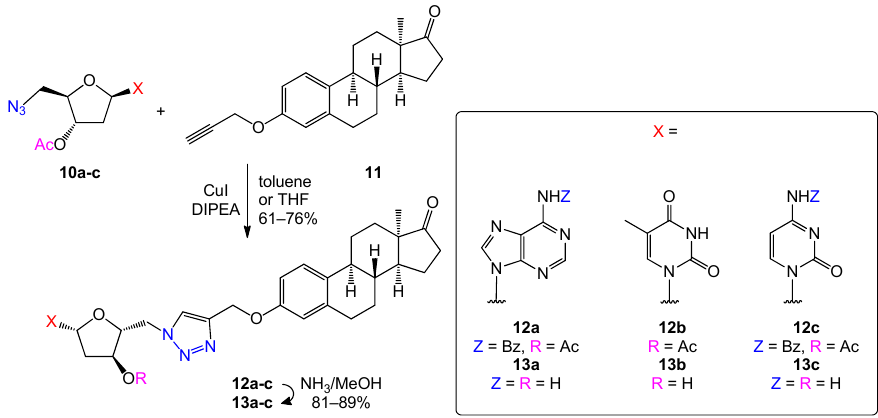
Table 1. Optimization of CuAAC conjugation reaction of 3’- O -acetyl-5’-azido-2’,5’-dideoxy- nucleosides and 3- O -propargyl-13 α